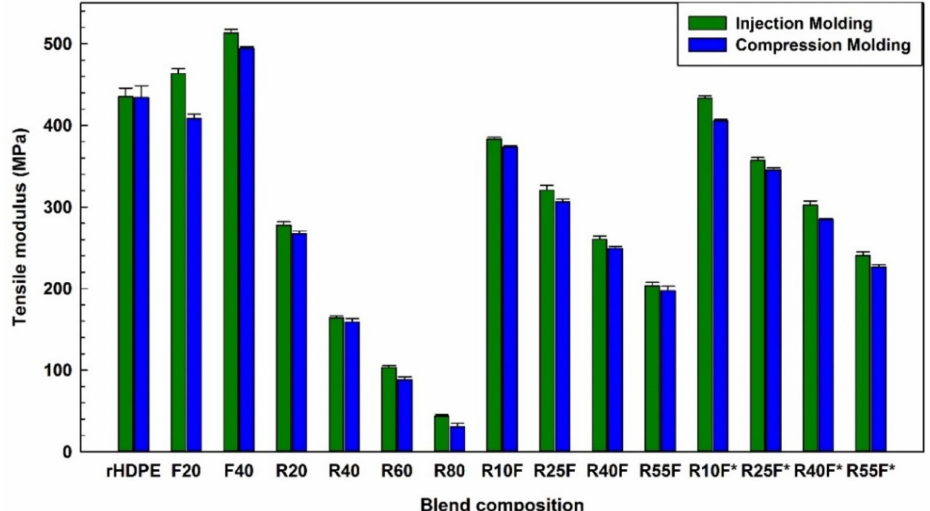
Figure 7. Tensile modulus of the composites (see Table 1 for